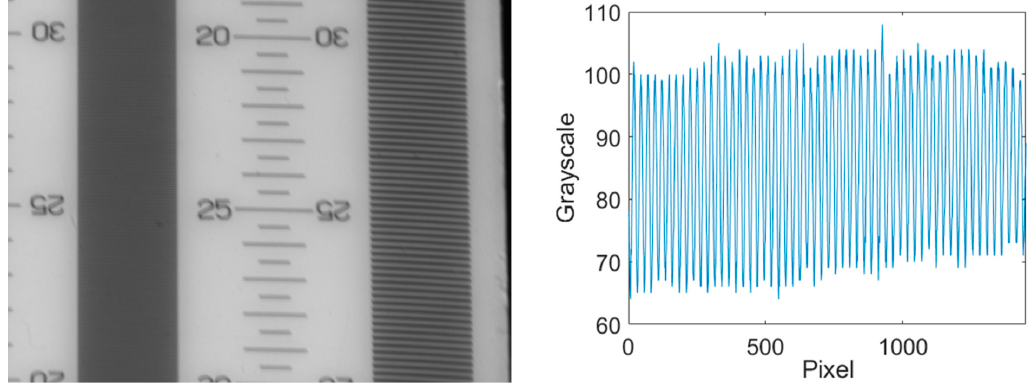
Figure 3. Images of a 1951 USAF resolution test chart at a distance of 45 cm with ( a ) and without ( b ) the liquid lens in front of the camera lens.